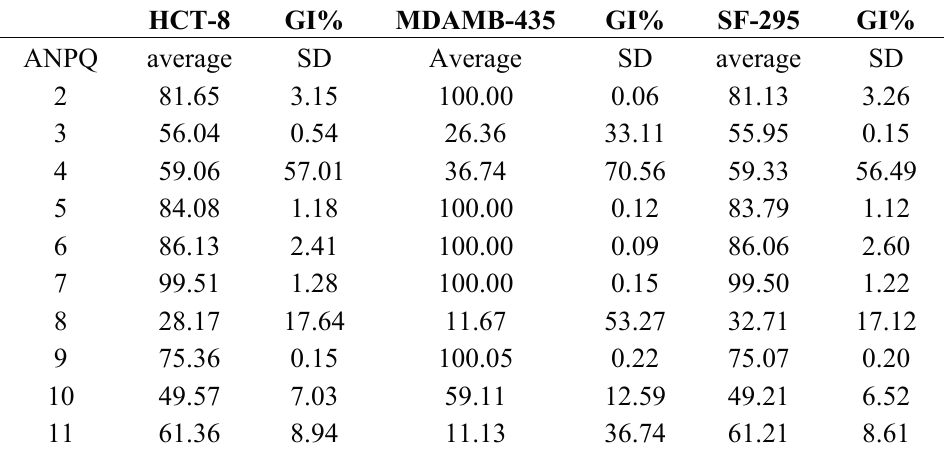
Table 1. Percentage of inhibition of cell growth (IC%) of the amino-naphthoquinones (ANPQ) at 5 µg/mL in three tumour cell lines from three independent experiments. Values are expressed as mean ± SDM.